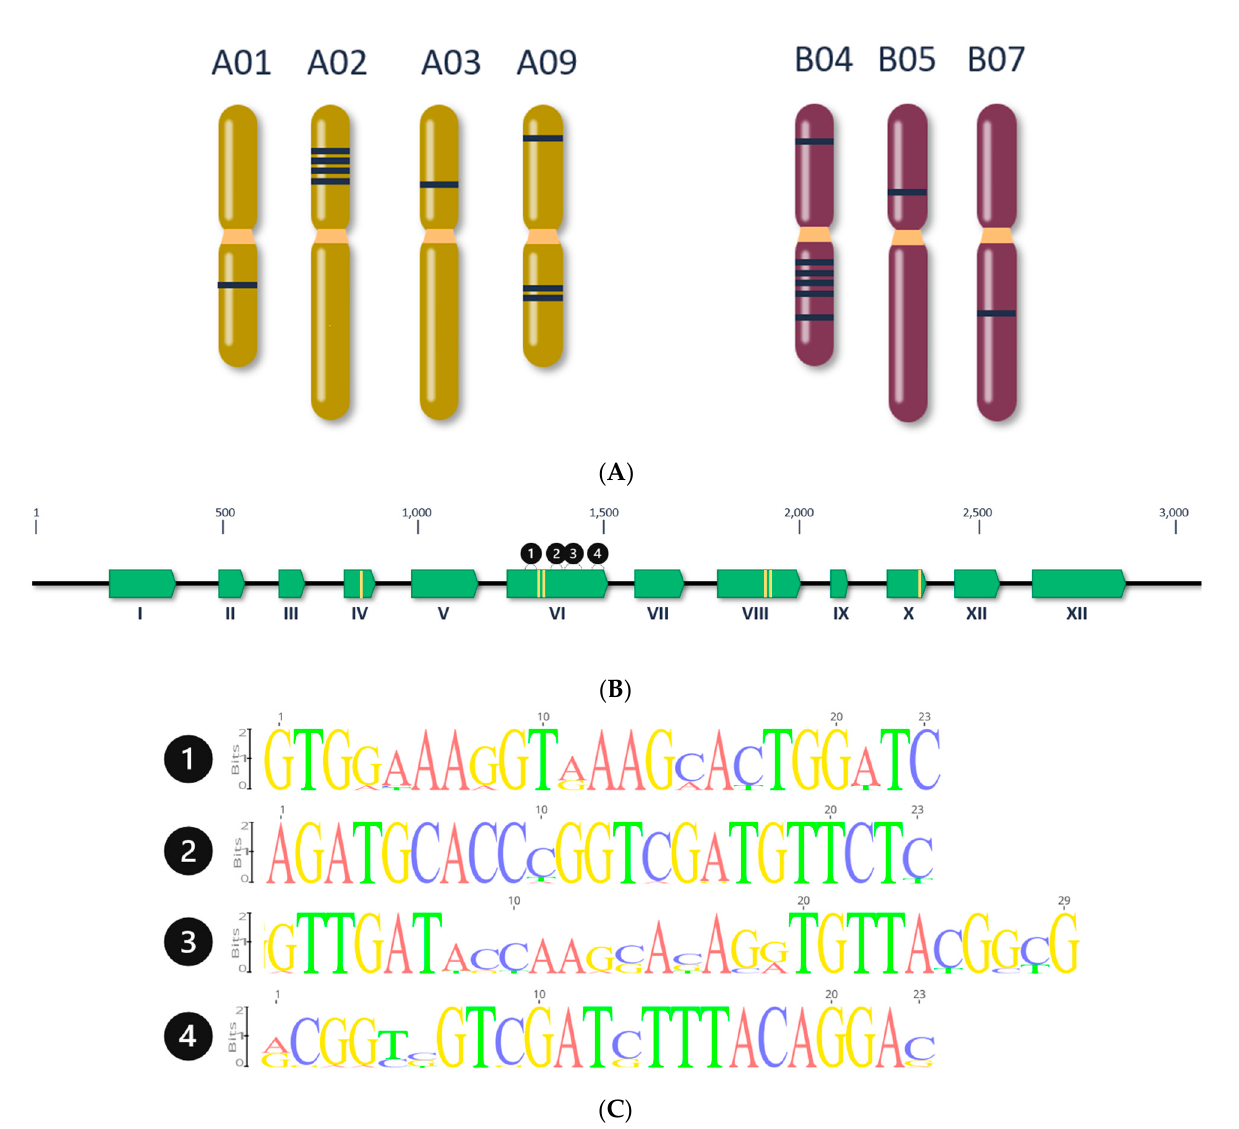
Figure 3. Genomic location of 17 type-I myrosinase genes in Brassica juncea . ( A ) Distribution of myrosinase genes across the A and B genomes. ( B ) Representative gene model for myrosinase . Yellow bars within green exons represent the six predicted active site residues in myrosinase as identified by Kumar and colleagues [23]. Editing spacers pair to sequences in Exon VI (regions 1, 2, 3, 4). ( C ) Sequence logos representing regions where guide sequences were designed in Exon VI of myrosi- nase. Alignments were manually curated. (1) PWg120225, PWg120226, PWg120227; (2) Pwg120231; (3) PWg120229, PWg120230; (4) PWg120228.